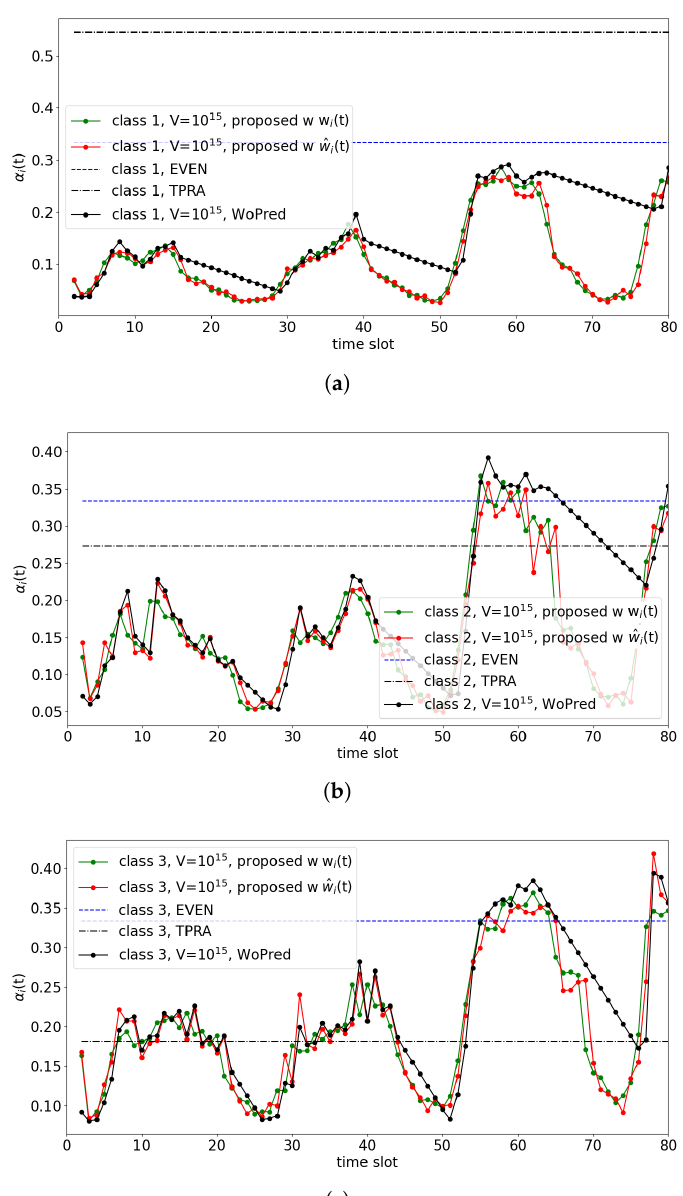
Figure 4. Comparison of α i ( t ) for three classes. ( a ) α 1 ( t ) over time, ( b ) α 2 ( t ) over time, and ( c ) α 3 ( t ) over